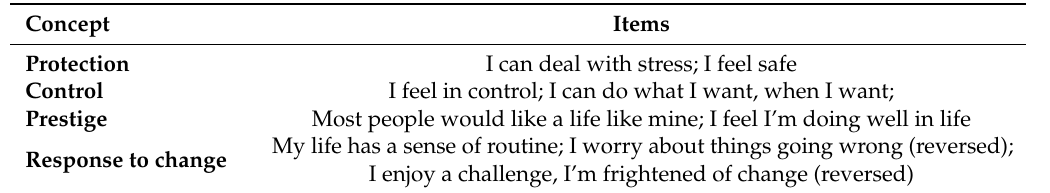
Table 3. The conception of ontological